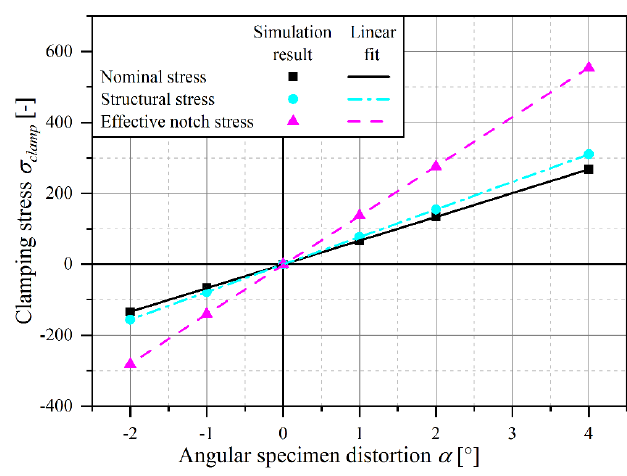
Figure 13. Clamping stress in dependence of angular specimen distortion.